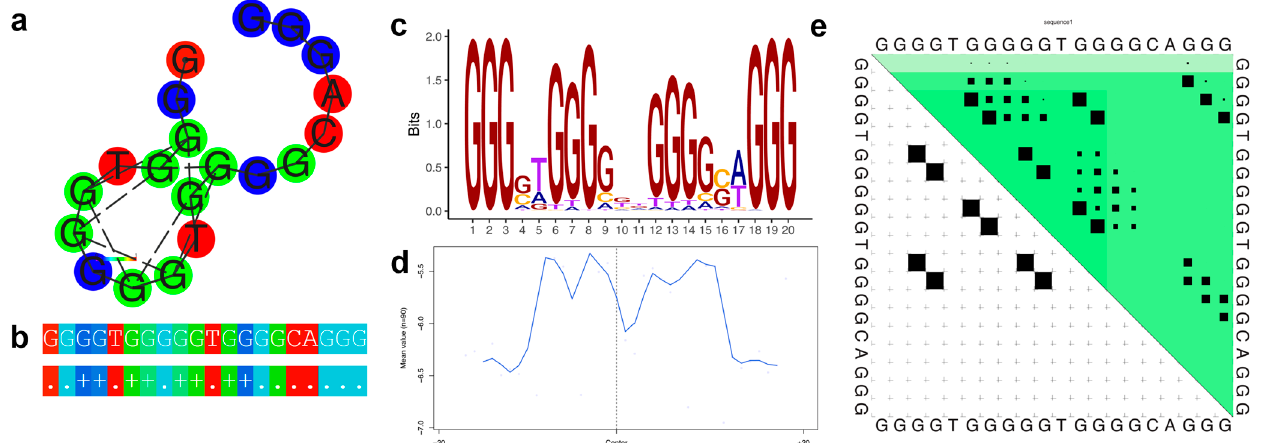
Figure 4. Thermodynamic properties for Family 32. ( a ) Centroid secondary structure with a minimum free energy of -18.0 kcal/mol using the consensus sequence of the family. ( b ) Dot-bracket notation showing the secondary structure. ( c ) Sequence logo representing the per base information content. ( d ) Electrostatic potential generated from all the sequences of the family using 10 flanking bases on either side of the identified G4. ( e ) Dot plot showing the substructures with the highest probabilities.